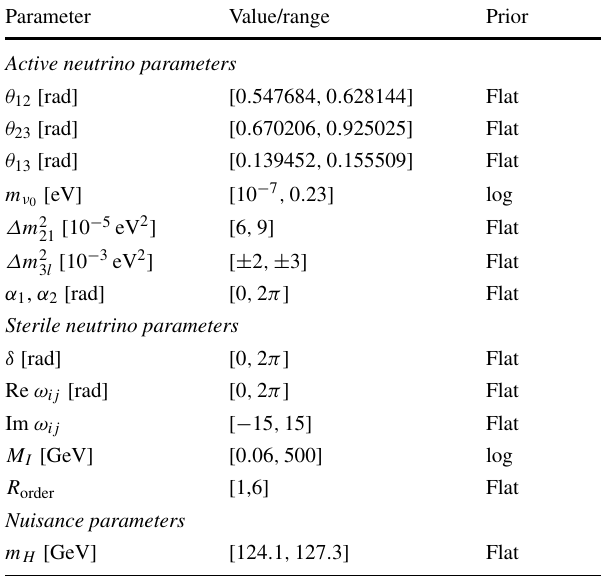
Table 5 Parameter ranges adopted for the full model scans, with + ( − ) for normal (inverted) hierarchy of the active neutrino